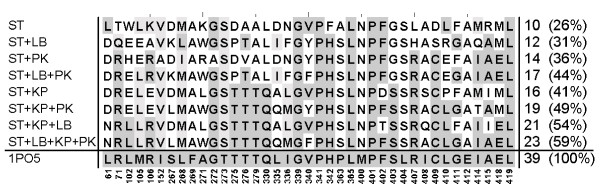
MSA showing the outcome of in silico recapitulation experiments for cytochrome P450 2B4. Different combinations of modules were used to generate models in a recapitulation experiment. The first column lists the module combination, the last column the number and fraction of correctly determined residues belonging to ACT_CENT. The last line gives the native sequence as deduced from pdb-entry 1po5. Recapitulated residues are indicated by a gray background. Abbreviations for modules are: ST (stability), LB (ligand binding), KP (knowledge-based potential) and PK (pKa values).